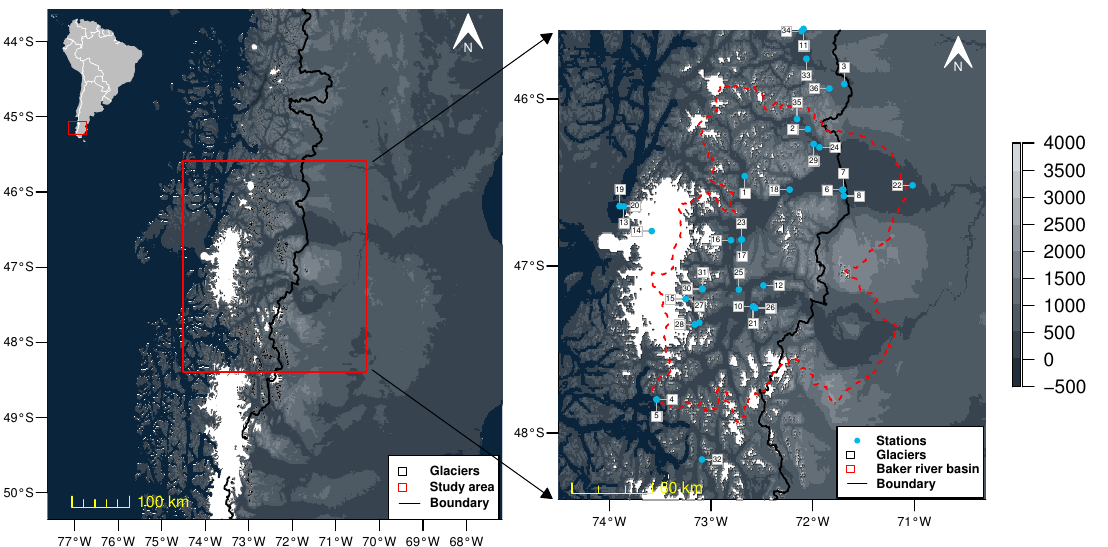
Figure 1. WRF domains: The full extension of the left figure corresponds to the coarser domain at a resolution of 22.5km. The inner domain at 4.5 km resolution corresponds to the rectangle in red. The right figure extension corresponds to the 4.5 km domain over the NPI and Baker river basin in the Chilean Patagonia. Source: Own elaboration with the covers from